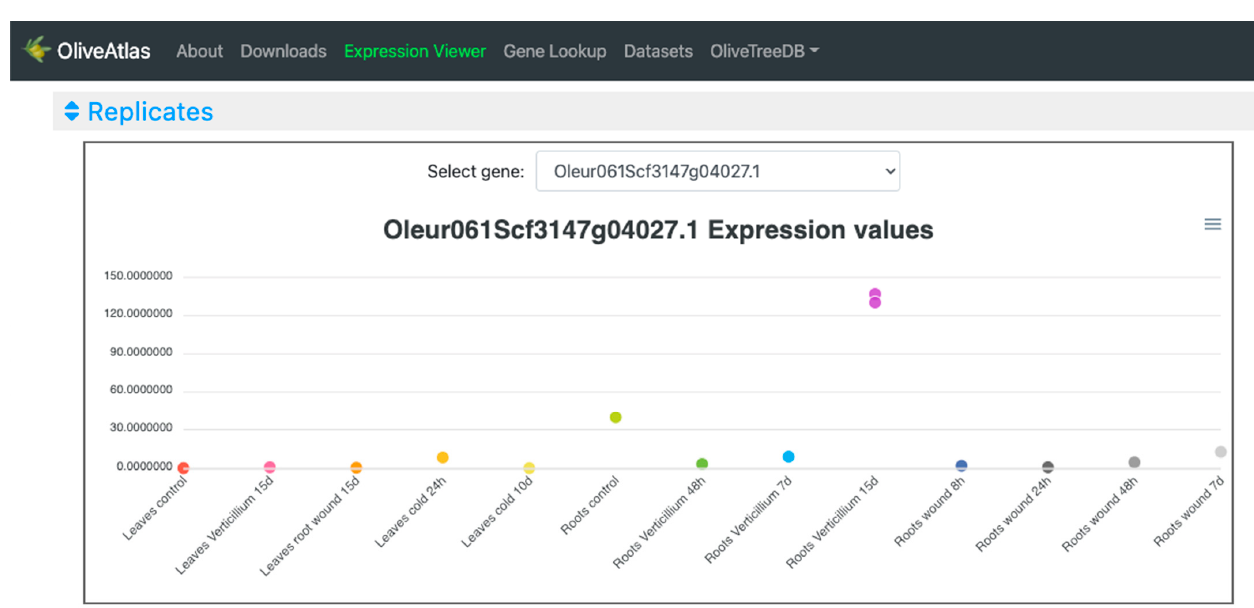
Figure 7. Expression values of replicates of an example gene in the “Expression viewer” tool of OliveAtlas.